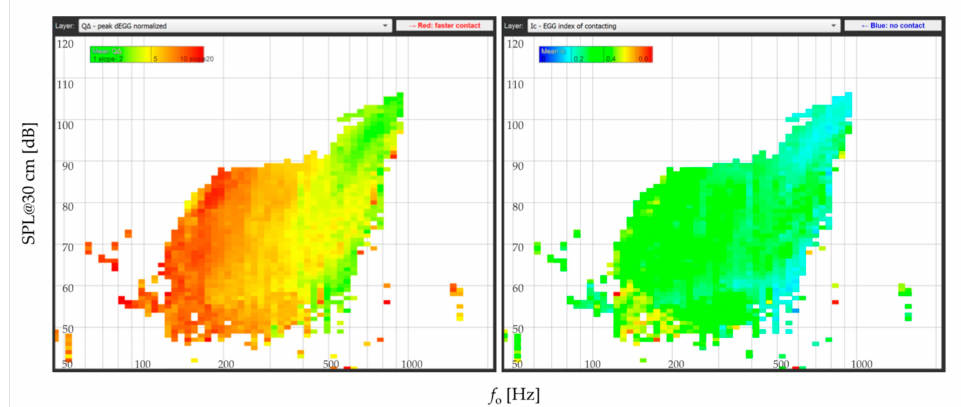
Figure 10. Real-time voice maps of a female singer’s voice displayed by FonaDyn software. ( Left panel ): normalized peak derivative ( Q ∆ ), with red and green indicating high and low values, respectively. ( Right panel ): index of contact ( I c ), with red and blue indicating high and low values, respectively.